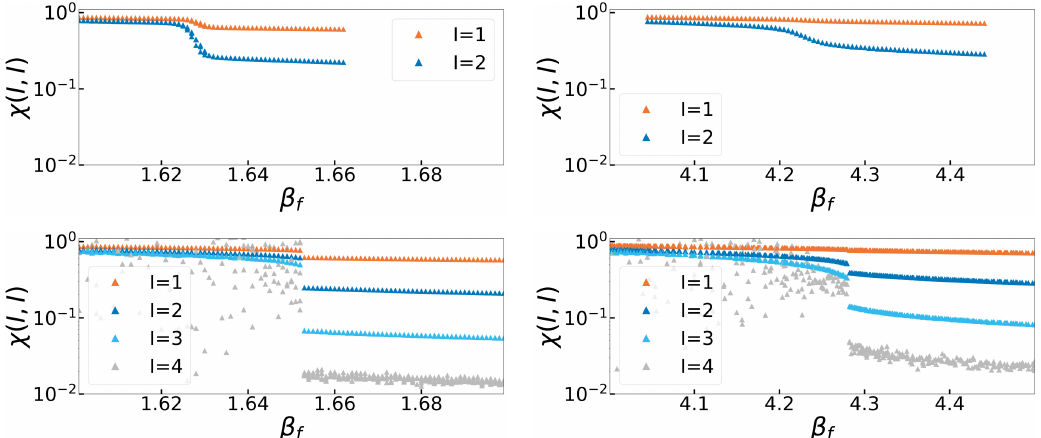
Figure 4 . Creutz’s ratios for β a = 0 ( left ) and β a = − 3 ( right ), L = 4 ( top ) and L = 8 ( bottom ). We present the results in a logarithm scale. In the deconfined phase, the Creutz ratio goes to zero in the limit of large Wilson loops. For the plots on the left hand-side, the error vary between 10 − 7 and 10 − 3 . For the plots on the right hand-side we show the results for 5 independent simulations (with distinct values of β f ), whose spread gives us a good estimate for the error. The errors are significantly smaller than the markers, except for I = 4 especially in the confined phase. This arises because the Creutz ratio is a ratio between very small numbers. The Wilson Loops in the confined phase are around 10 − 7 , compared with 10 − 4 in the deconfined